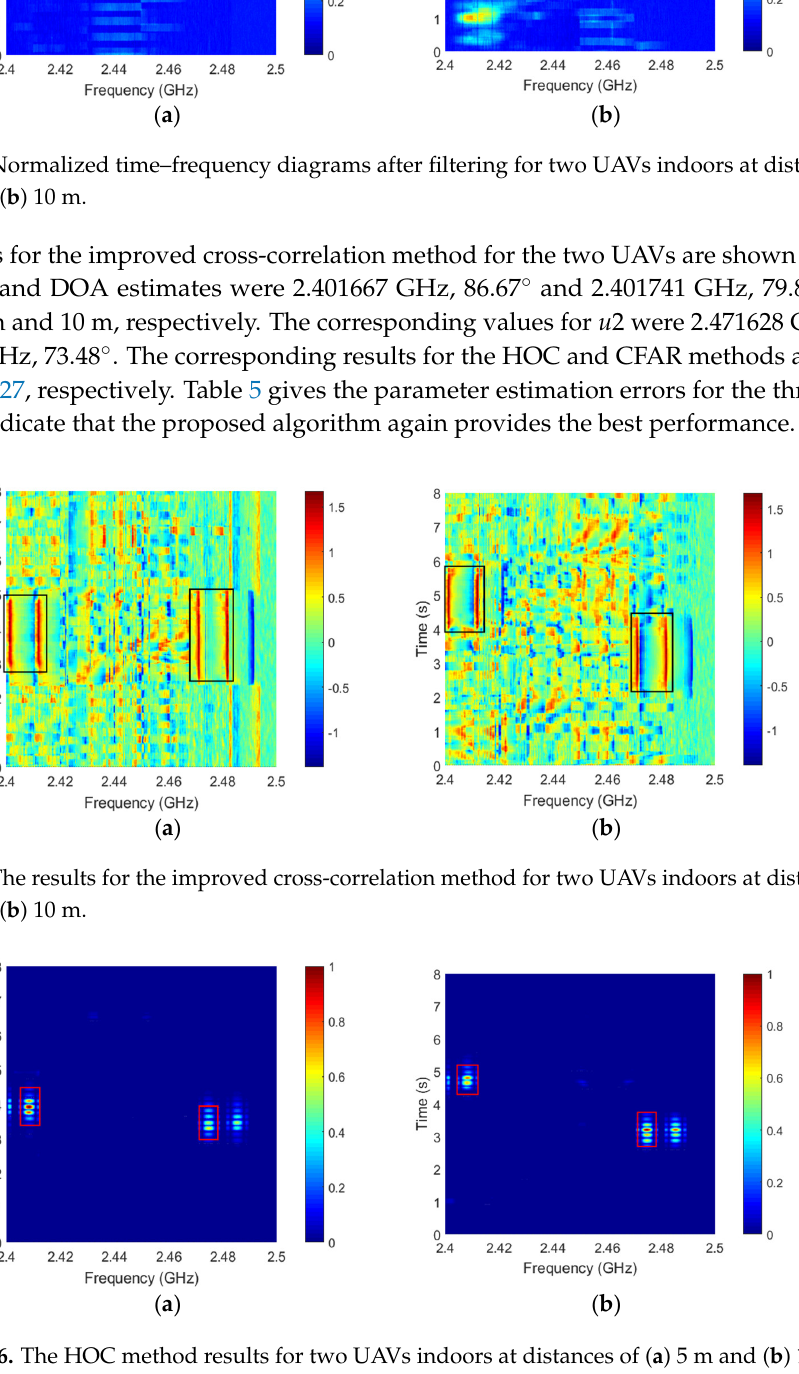
( a ) ( b ) Figure 27. The CFAR method results for two UAVs indoors at distances of ( a ) 5 m and ( b ) 10 m. Table 5. Parameter estimation errors for two UAVs using three methods in an indoor environment. Method